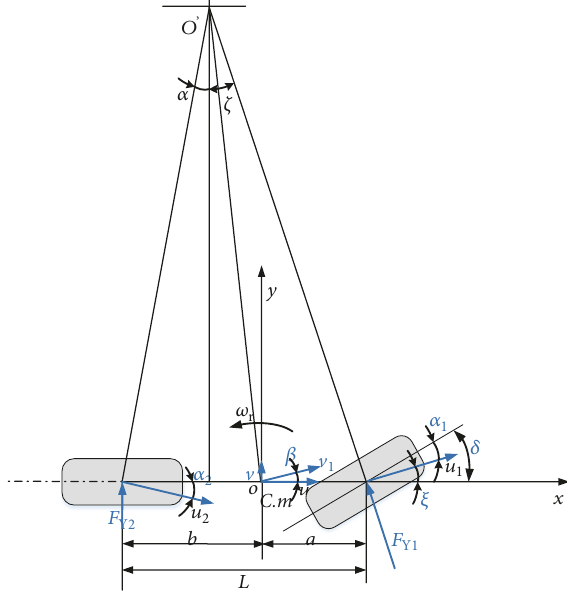
Figure 1: Two-degree-of-freedom vehicle